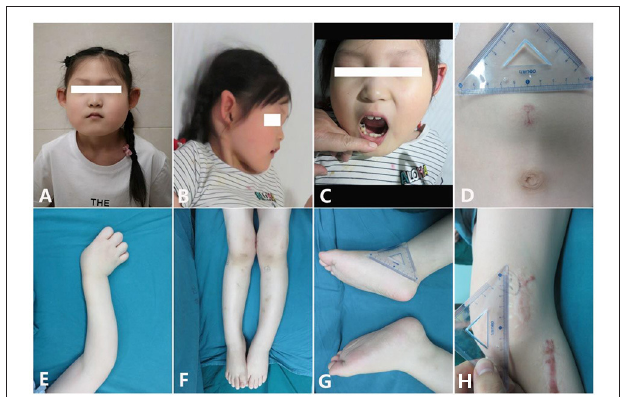
FIGURE 1 | Clinical characteristics of the patient [age 6 years and 6 months; (A,B) Facial features: small mouth with thin lips, pointed ears with no obvious earlobe; (C) sparse and irregular teeth; (D) superficial hemangioma; (E) tortuous arm with ulnar deviation of her wrists; (F) genu valgum; (G) big feet and flat feet; (H) scar hyperplasia].